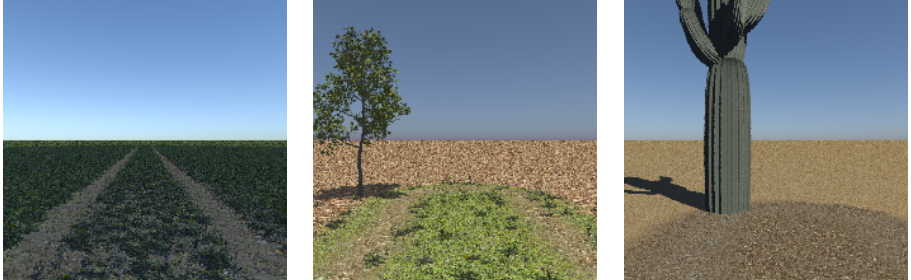
Figure 4. Sample images from four-class random synthetic dataset. Best viewed in